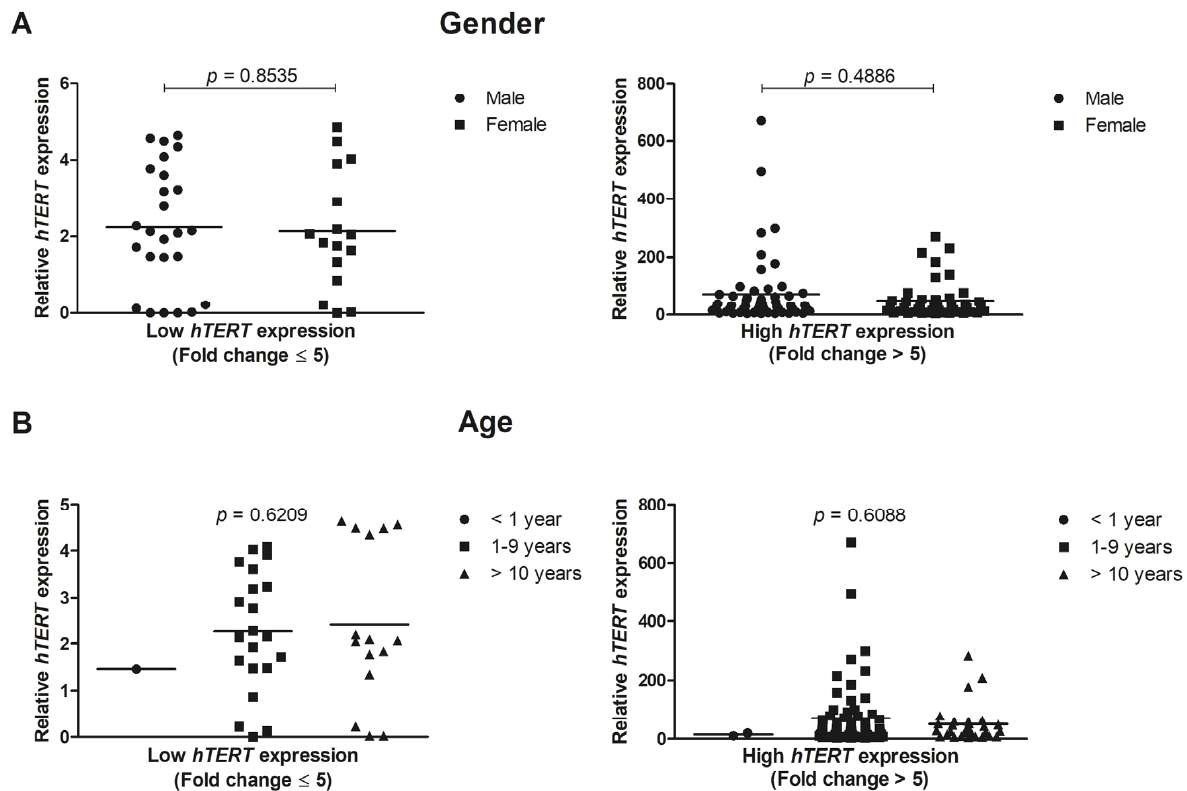
Figure 3. The ALL patients ( n = 148) were separated into two groups, with low (fold change ≤ 5) and high (fold change > 5) hTERT expression. ( A ) Gender and ( B ) Age did not imply significant alterations between groups with low or high hTERT gene expression. Relative hTERT expression was calculated using ABL and GAPDH as endogenous normalizers. Data are presented as the median and each dot plot represents the hTERT expression in a single patient. For statistical analysis, the Shapiro–Wilk normality test was performed, followed by the Kruskal–Wallis test and Dunn’s Multiple Comparison post-test for age analysis or t-test for